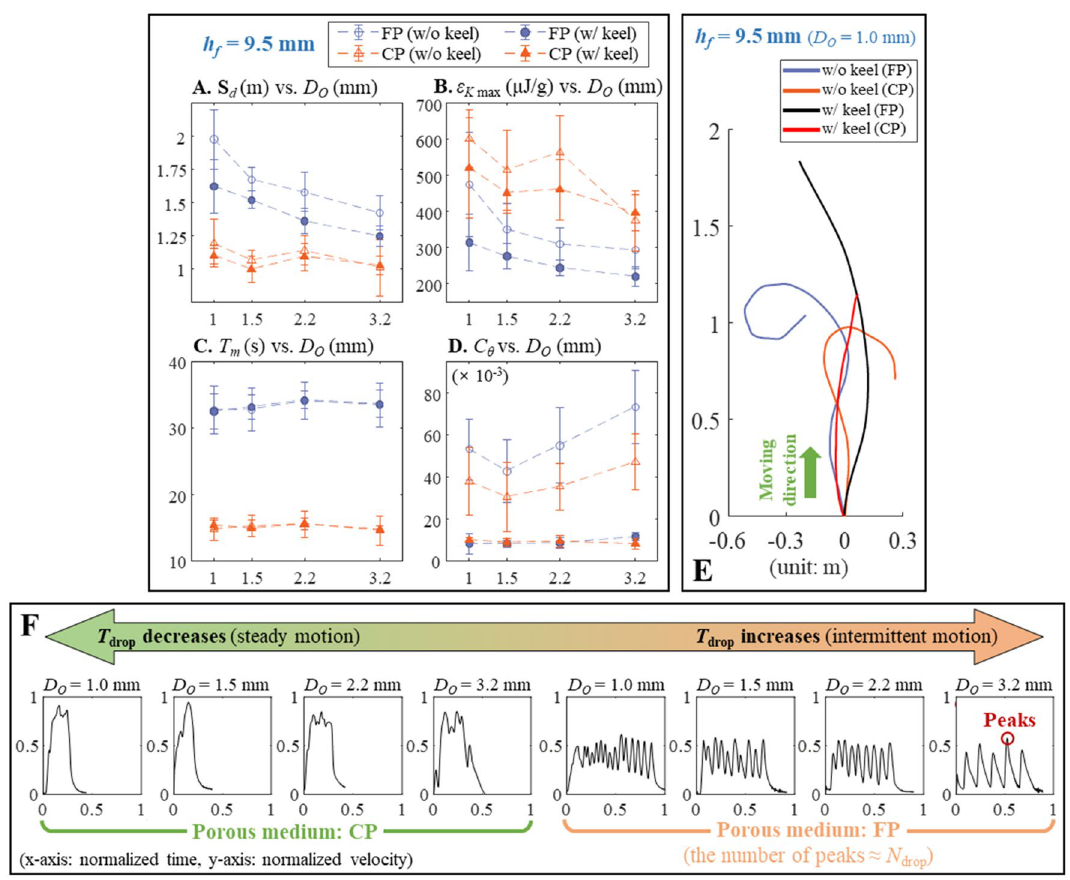
Figure 4. Robot locomotory characteristics at an h f = 9.5 mm. ( A ) Traveled distance ( S d ) versus D O . ( B ) Energy density of fuel ε K ,max versus D O . ( C ) Duration of motion T m versus D O . ( D ) Moving trajectory characteristic C θ versus D O ( n = 5 for A – D ). ( E ) Moving trajectories of some selected cases. ( F ) The variation of normalized velocity of the robot upon T drop change. Note that all the error bars denote standard